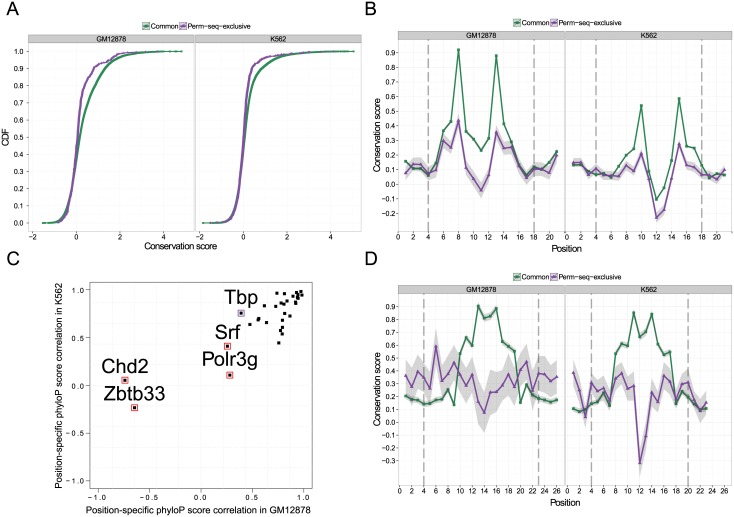
Conservation analysis of the common and Perm-seq-exclusive peak sets.(a) Empirical cumulative distribution functions (CDFs) for average phyloP scores of Usf1 binding sites from the Common and Perm-seq-exclusive Usf1 peaks in GM12878 and K562 cells, respectively. Positive scores indicate conservation and negative scores indicate acceleration. (b) Mean position-specific phyloP scores of the Usf1 binding sites for Common and Perm-seq-exclusive Usf1 peaks in GM12878 and K562, respectively. Shaded areas denote ± one standard error of the mean profile. (c) Pearson correlations between the mean position-specific phyloP scores of the binding sites from the Common and Perm-seq-exclusive peak sets. Purple and red circles indicate that correlations are not significantly different than zero only in GM12878 and in both GM12878 and K562 cells, respectively. (d) Mean position-specific phyloP scores of the Zbtb33 binding sites from the Common and Perm-seq-exclusive Zbtb33 peaks in GM12878 and K562 cells, respectively.